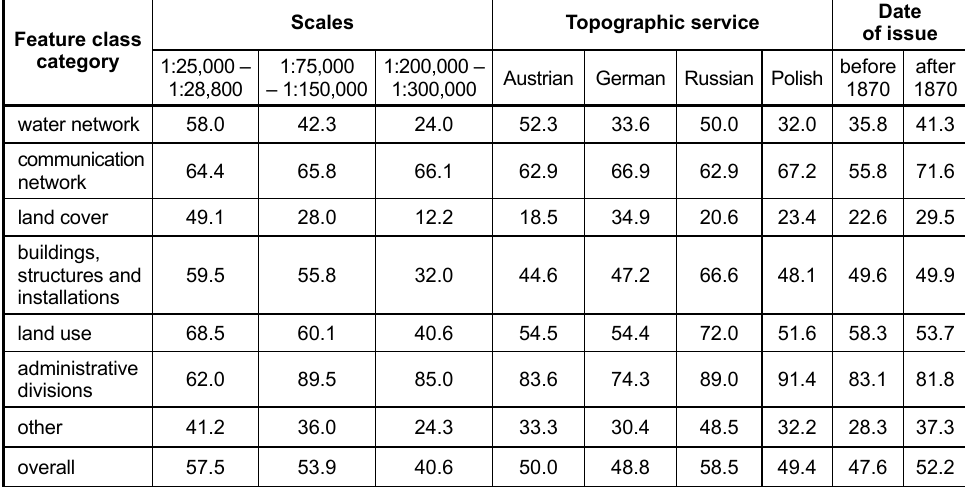
Tab. 5. Percentage decrease of feature types after harmonization for individual feature class categoies, broken down into different maps in terms of: scale, topographic service and date of issue